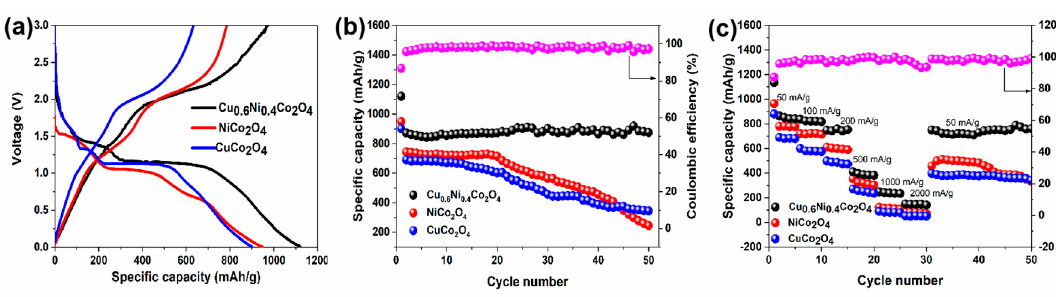
2 O 4 , ( b ) CuCo 2 O 4 , and ( c ) Cu 0.6 Ni 0.4 Co 2 O 4 .